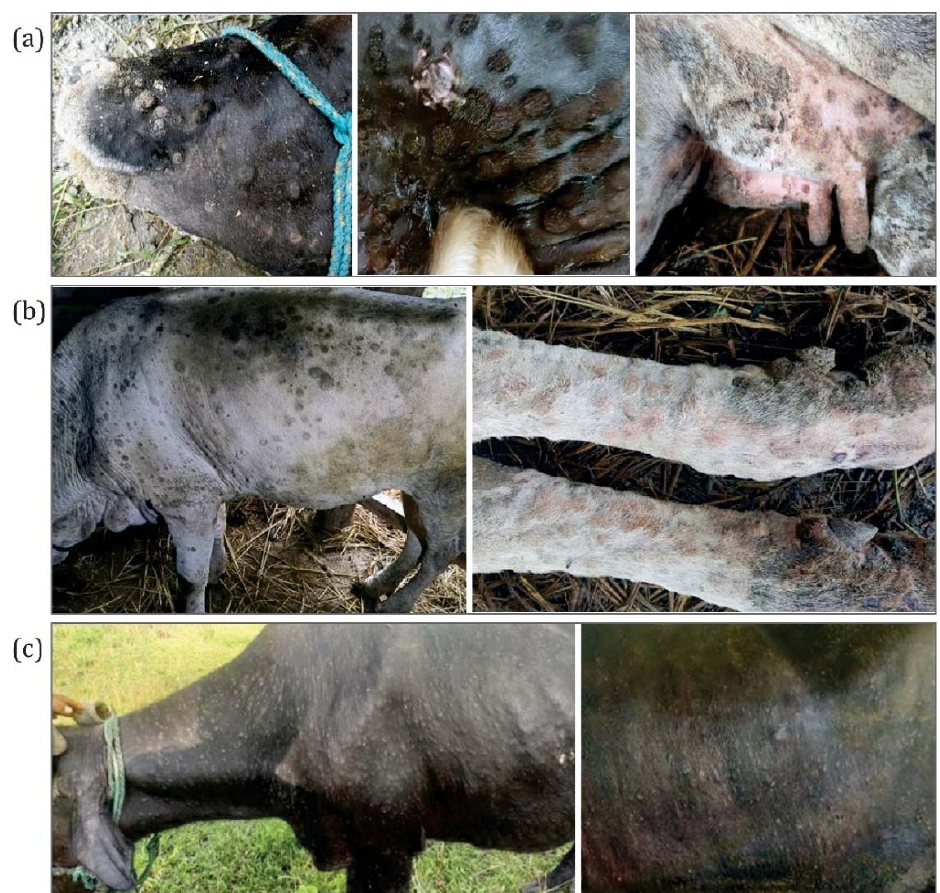
Figure 2. Lesions in LSD suspected animals. ( a ) Local Terai cow with nodular skin lesions over the face, neck, and udder. ( b ) Local cow with nodular skin lesions all over the body and limbs. ( c ) Buffalo showing small skin nodules all over the body. Table 3. PCR-based snap back assay results for detection and genotyping of LSDV.